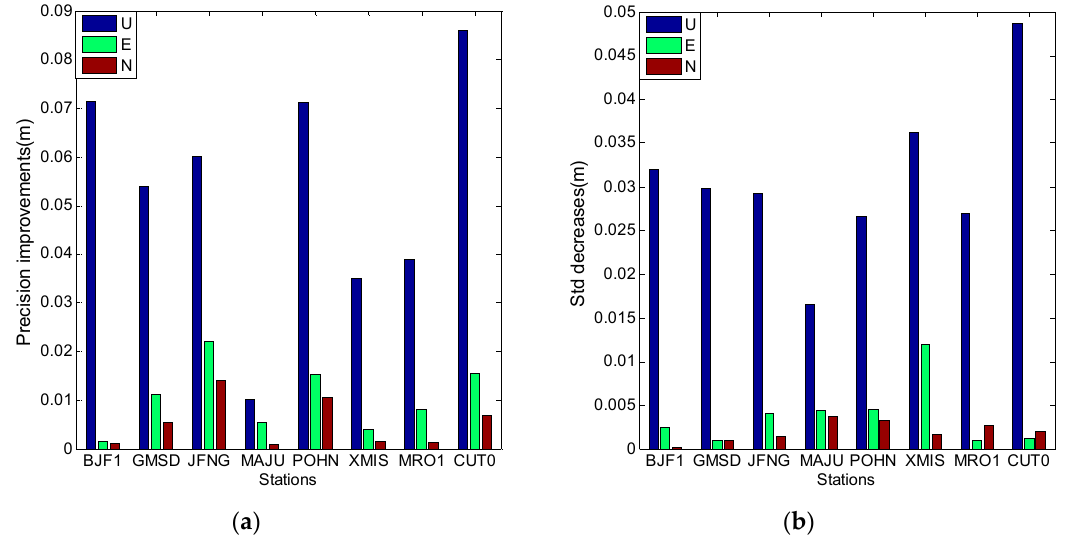
Figure 19. The SPP results estimated by using ionosphere-free combination of the first and third frequencies ( a ) describes the precision improvements after model correction; ( b ) Describes the Std decreases after the model correction.